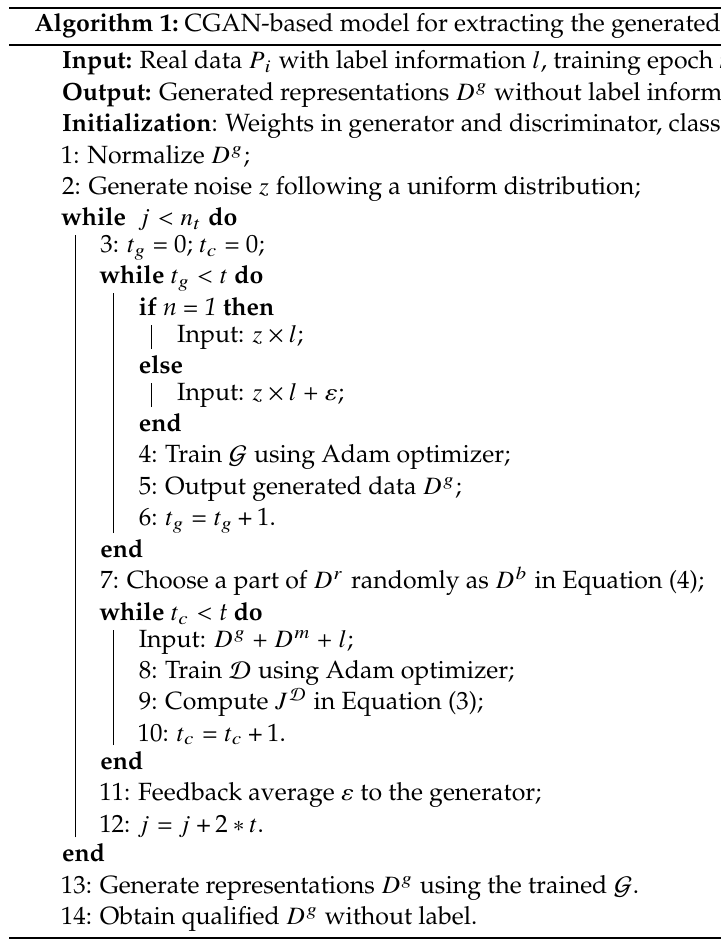
Algorithm 1: CGAN-based model for extracting the generated representations without label information Input: Real data 𝑃 𝑖 with label information 𝑙 , training epoch 𝑛 𝑡 , the number of iterations 𝑡